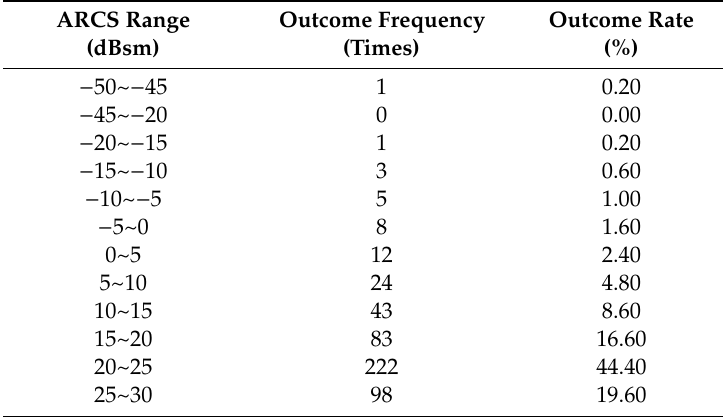
Table 1. The ARCS range, the outcome frequencies and the outcome rate at the uniform distribution. ARCS Range